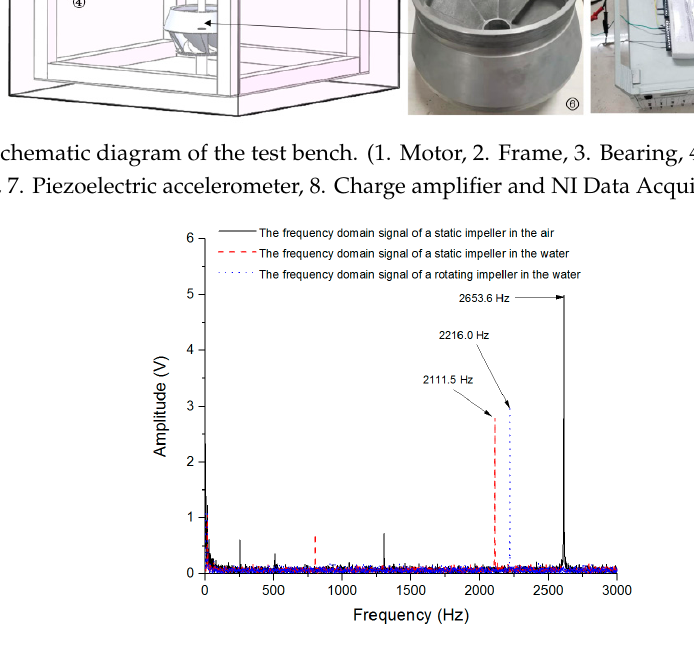
Figure 2. Test signal spectrogram.